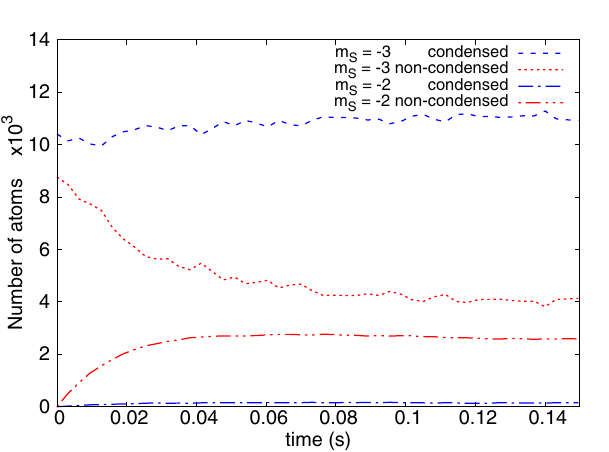
3 (dotted) and m s 2 (dash- = − = −